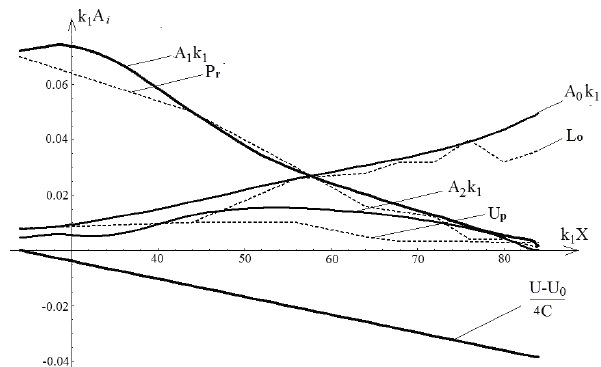
Figure 5. Dashed curves show amplitudes of the waves for pri- mary (Pr), lower (Lo) and upper (Up) sidebands obtained from experiments conducted by Ma et al. (2010). The solid lines ( A 1 ,A 0 ,A 2 ) are the wave amplitudes calculated in modeling. (U − U 0 )/( 4 C) shows the no-dimensional variable current, where C is the initial phase speed of the primary wave, U 0 = − 0 . 25 m/s ; k 1 = 4 . 1 /m,C = 1 . 56 m/s,T = 1